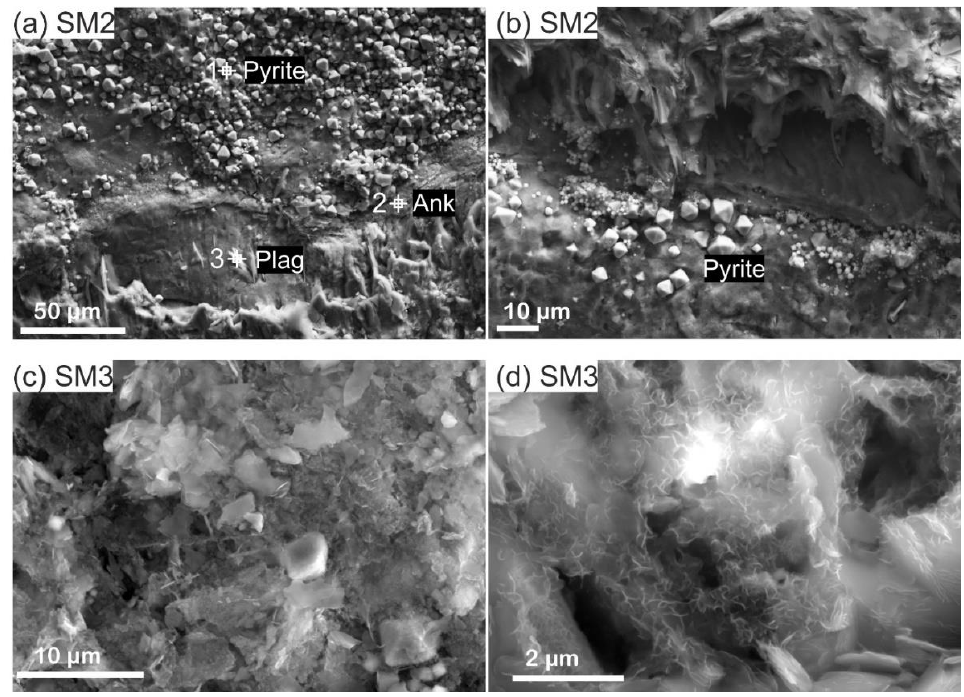
Figure 10. Scanning electron (SE) micrographs of the fracture surface of sample SM2 ( a , b ) and sam- ple SM3 ( c , d ) after the experiments.